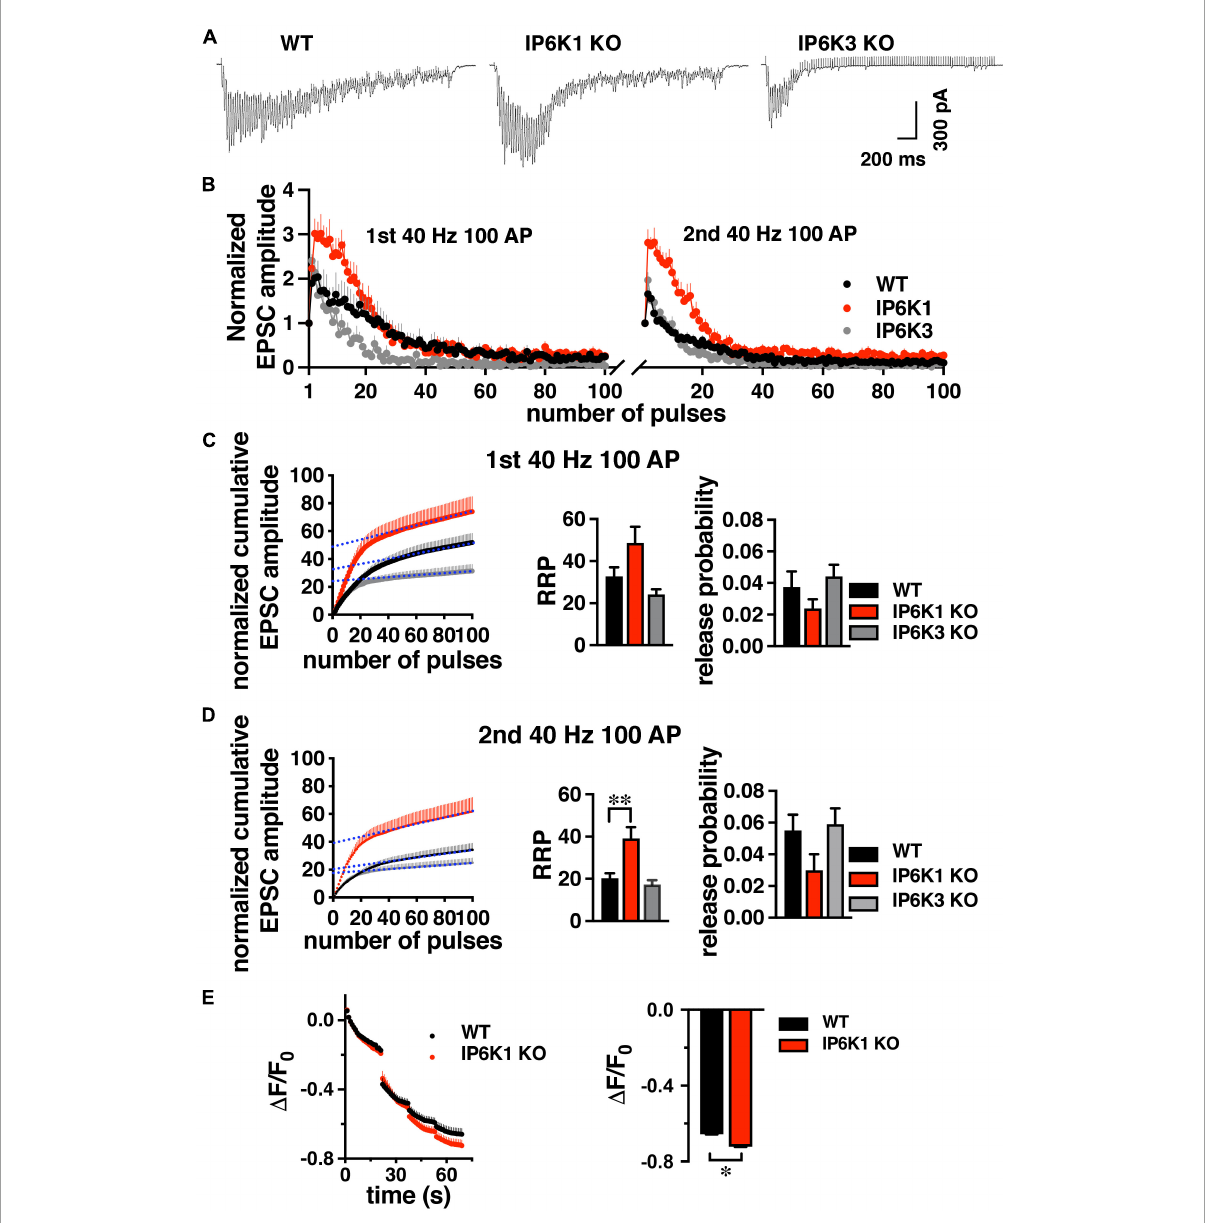
FIGURE7 Response of WT and IP6K1 KO in hippocampal VGLUT1 synapses to high frequency repeated stimulation. (A) Representative traces of CA1 EPSCs evoked by 100 stimuli at 40 Hz in WT ( n = 7) and IP6K1 ( n = 6) and IP6K3 ( n = 5) KO slices. (B) Summary plot of EPSC amplitude, normalized to the first EPSC amplitude, in response to two 40 Hz 100 pulse stimuli with a 7 min recovery between stimulus trains. (C) Cumulative EPSC amplitude during the first 40 Hz stimulus train in WT and IP6K1 KO. EPSC amplitudes are normalized to the first stimulus. The last 20 data points are fitted to a linear regression and extrapolated to time zero to estimate RRP size. Release probability is estimated by dividing the first EPSC amplitude by the RRP size. (D) Cumulative EPSC amplitude as in C for the second 40 Hz stimulus train. ∗∗ p < 0.01, ANOVA. (E) Cultured hippocampal WT and IP6K1 KO neurons were loaded with FM1-43 using an 80 Hz 10 s stimulus. After washing, the extent of dye release is measured upon unloading from the RRP with a 30 Hz 2 s stimulus, then the remaining recycling pool with three 40 Hz 10 s stimuli. All data are presented as means ± SEM, unless otherwise noted. ∗ p < 0.05, t